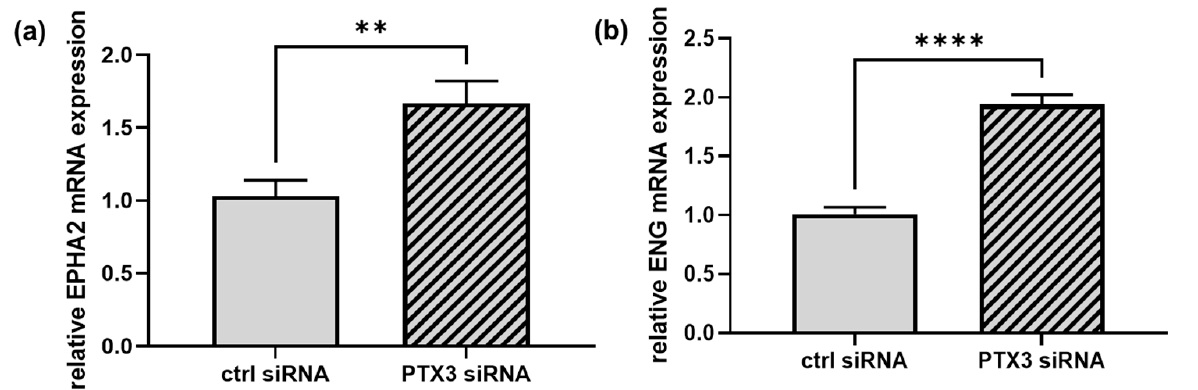
Figure 2. RT-qPCRs were performed on mRNAs prepared from ECs transfected for 48 h with control siRNA (CTRL siRNA, solid bars) or PTX3 siRNA (diagonal bars). EPHA2 ( a ) and ENG ( b ) mRNAs were normalized to the housekeeping gene GAPDH. ( a ), ** p < 0.001, n = 6. ( b ) **** p < 0.0001, n = 6.